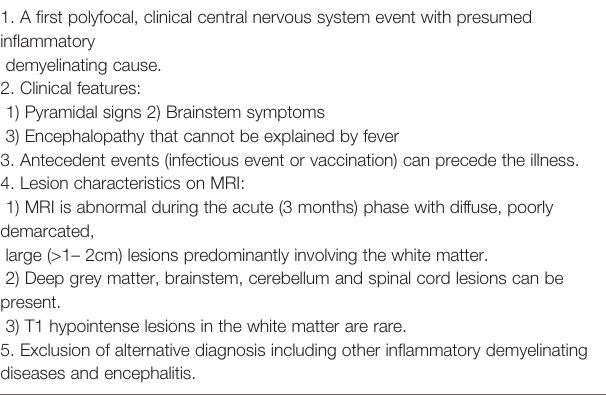
TABLE 6 | A summary of the key observations in ADEM adults. 1. A fi rst polyfocal, clinical central nervous system event with presumed in fl ammatory demyelinating cause. 2. Clinical